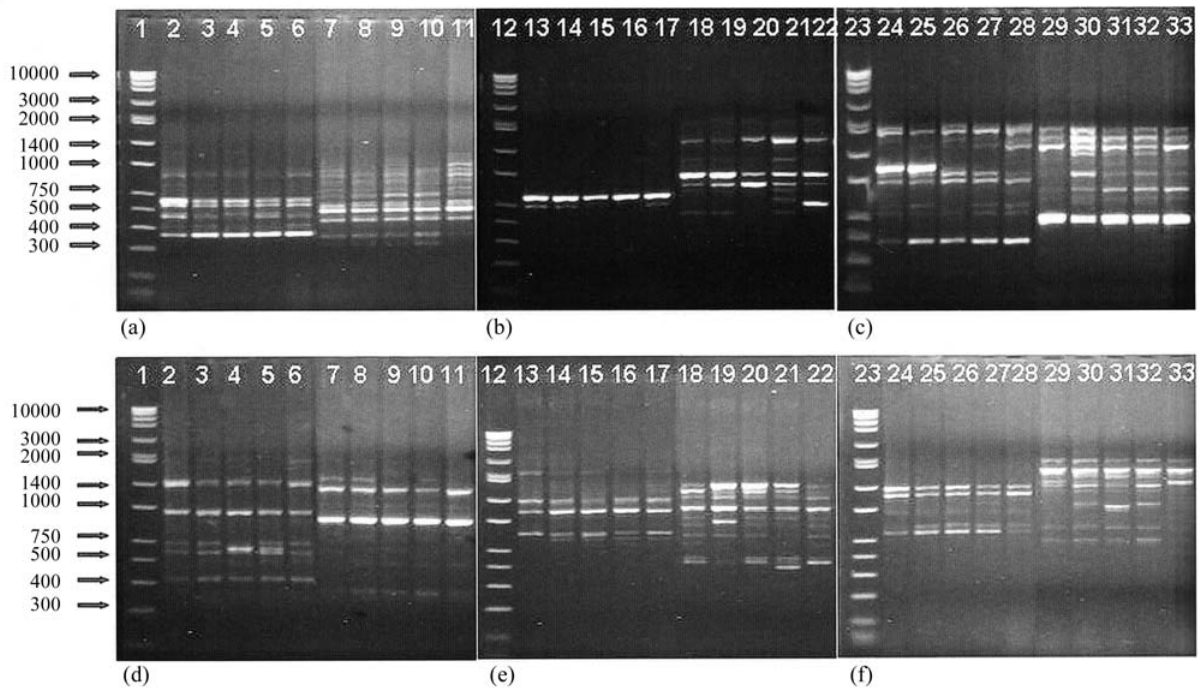
Figure1 -TheRAPDfragmentpatternsof Badisbadis (lanes2-6,13-17,24-28)and Dariodario (lanes7-11,18-22,29-33)usingprimer(a)OPA-03,(b) OPA-08 (c) OPB-08 (d) OPB-12 (e) OPB-14 (f) OPB-18. Lane 1, 12, 23 represent wide range DNA molecular weight